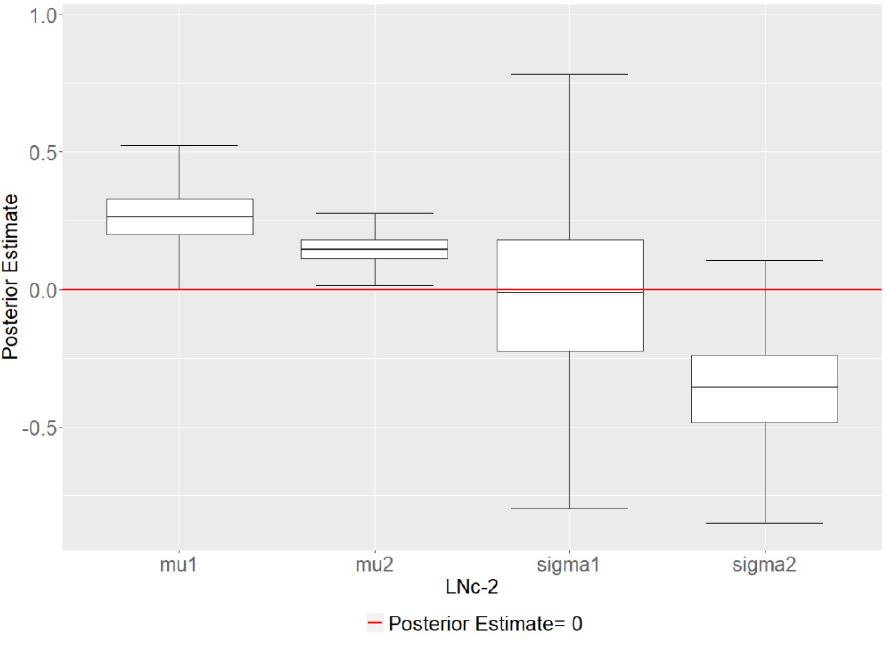
Figure 4. The boxplot of parameters in LNc-2 model.